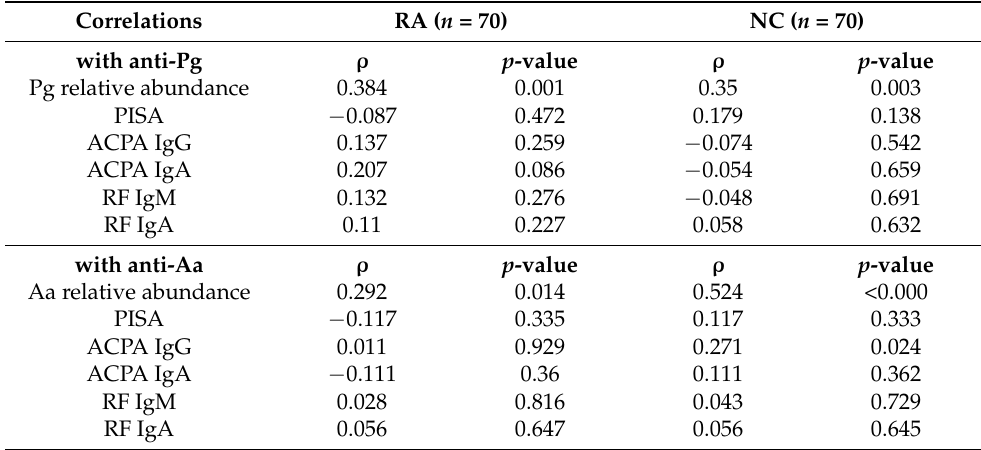
Table 3. Correlations (Spearman’s ρ ) of anti- P. gingivalis (Pg) and anti- A. actinomycetemcomitans (Aa) antibodies with the subgingival relative abundance of Pg and Aa (number of sequences), periodontal inflamed surface area (PISA), and the RA autoantibodies ACPA and